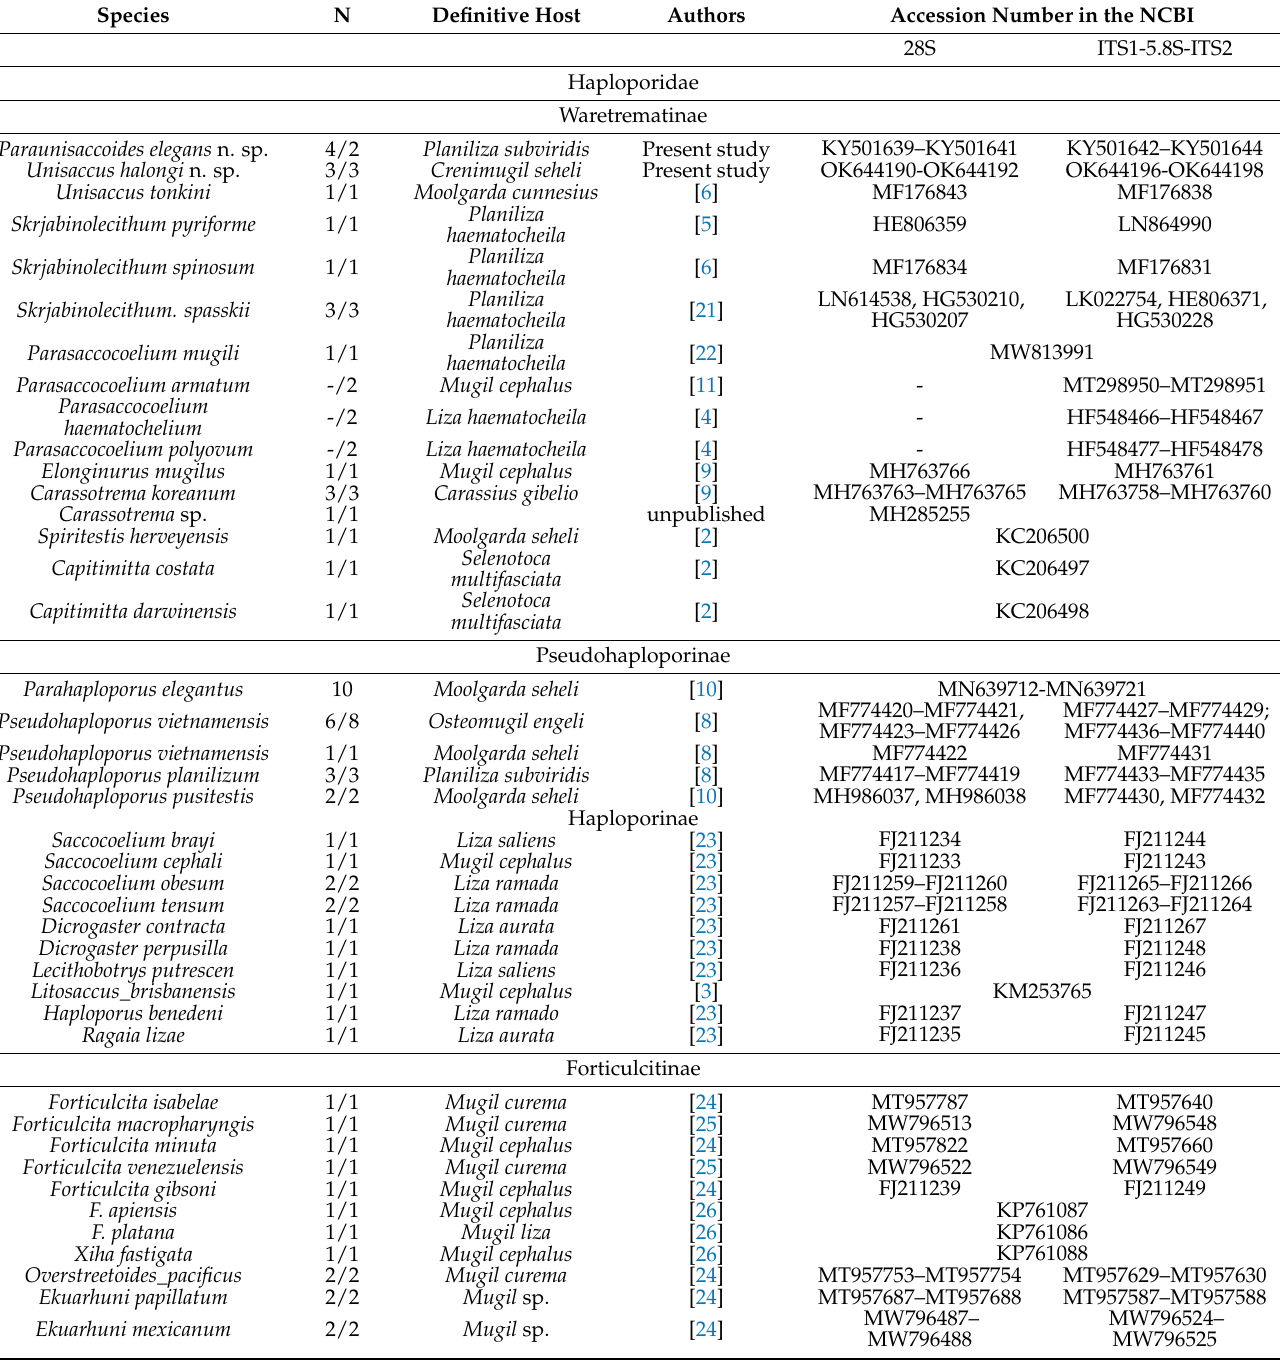
Table 1. List of taxa used for molecular